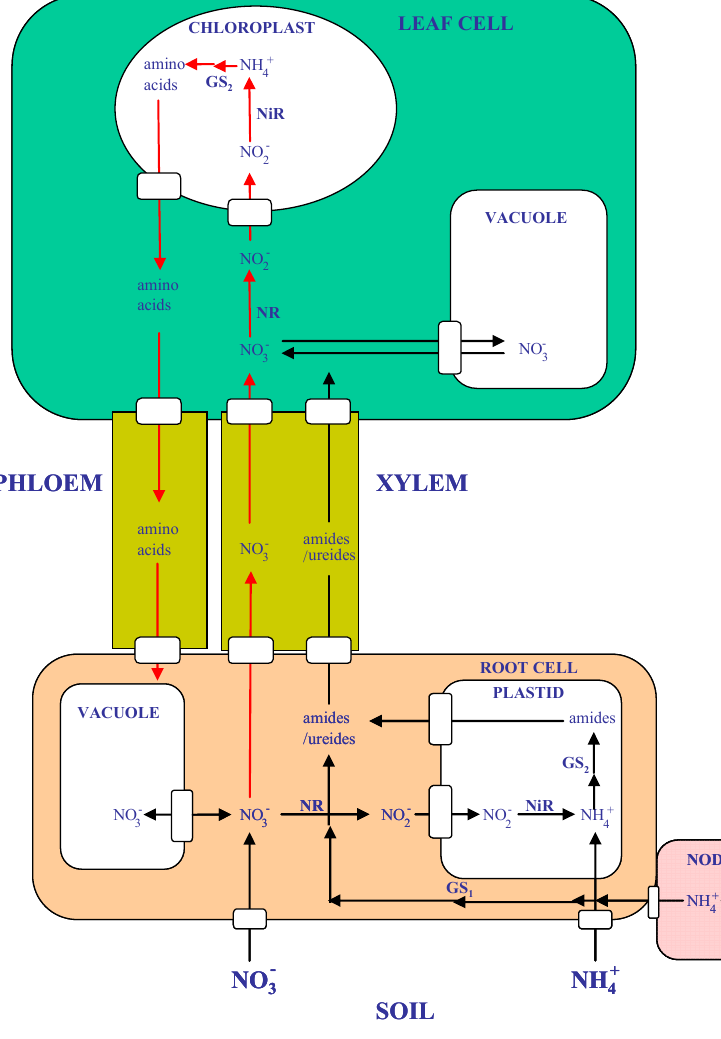
Figure 1. Nitrogen utilization in legume plants. Simple arrows represent single step reaction, while consecutive arrows represent multiple-step reactions. GS glutamine synthetase; GS , plastidic glutamine synthetase; NR, nitrate reductase; NiR, 2 nitrite